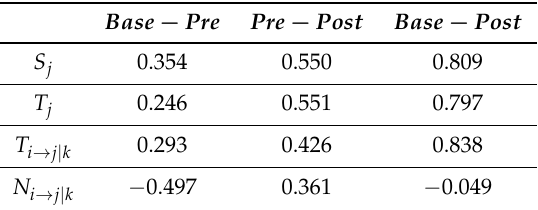
Table 3. Cohen’s d effect size-Focal seizures-Scalp